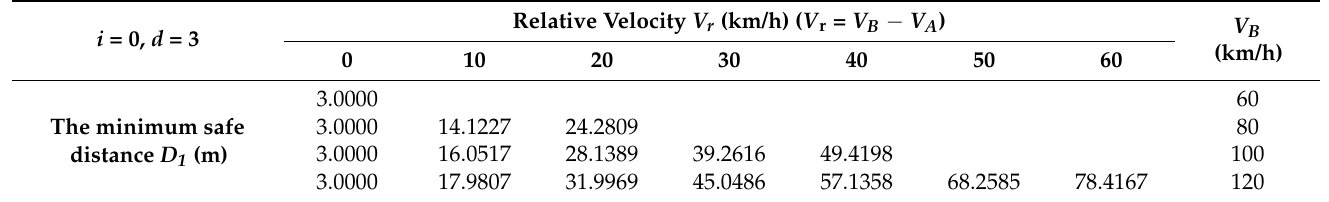
Figure 5. Changes in the sufficient safe distance D 3 with various V B and V r when i = 0 and d = 3. Table 2. The minimum safe distance D 1 based on V B between 60 and 120 km/h when i = 0 and d = 3.